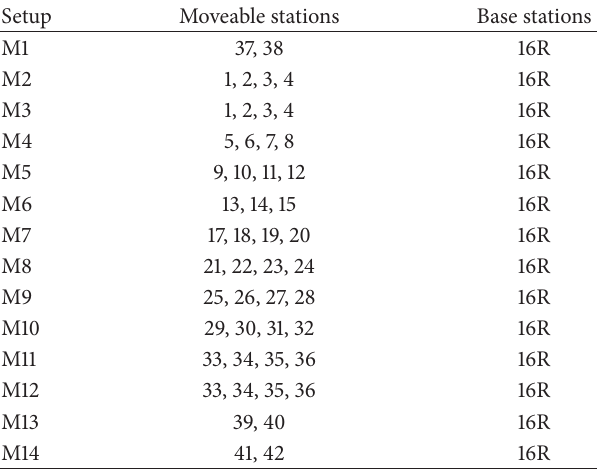
Table 5: Setup of stations during the ambient vibration testing.